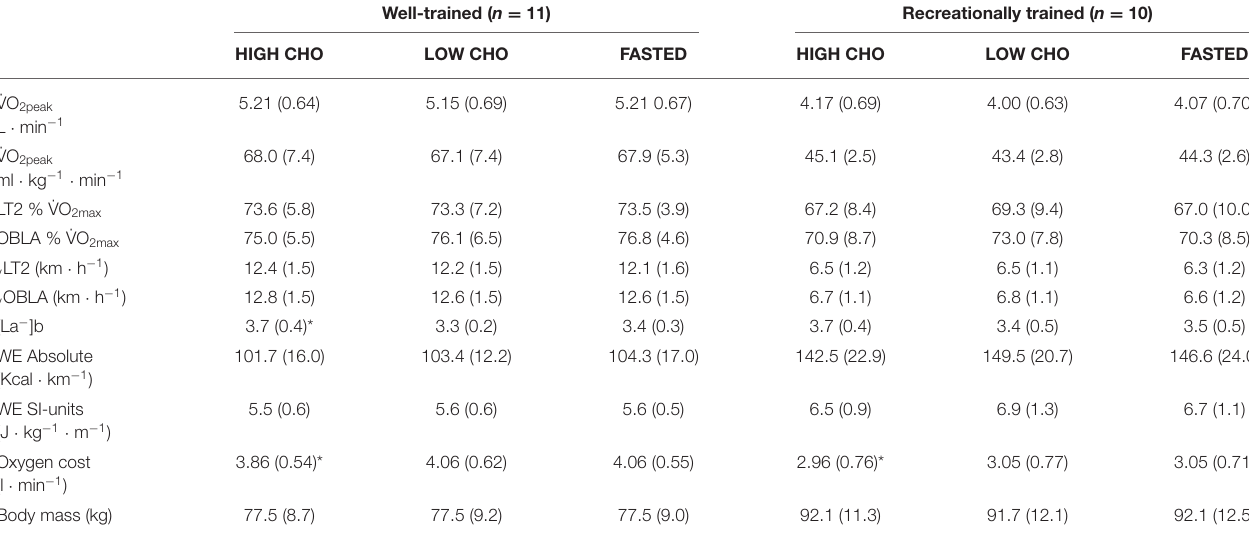
TABLE 3 | Effect of pre-event meal on peak oxygen uptake, lactate threshold, and work economy in well-trained and recreationally trained participants.